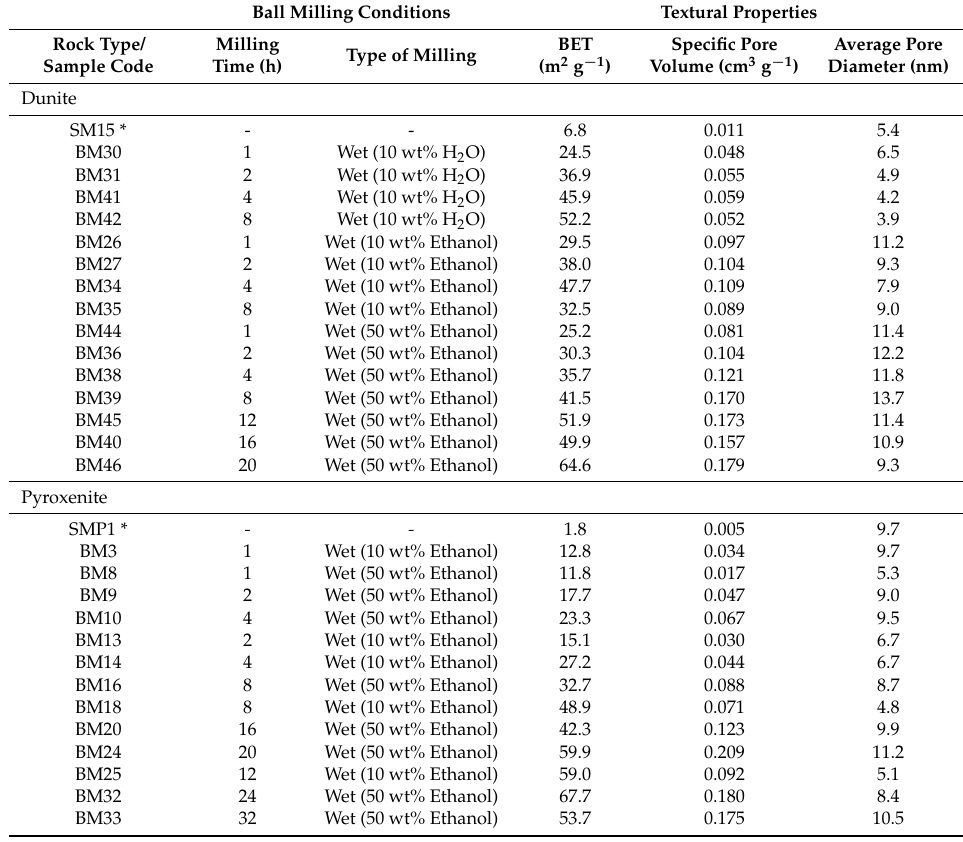
Table 1. Ball milling conditions and textural properties of the unmilled and ball-milled ultramafic rocks (data from Rigopoulos et al. [19,32]).